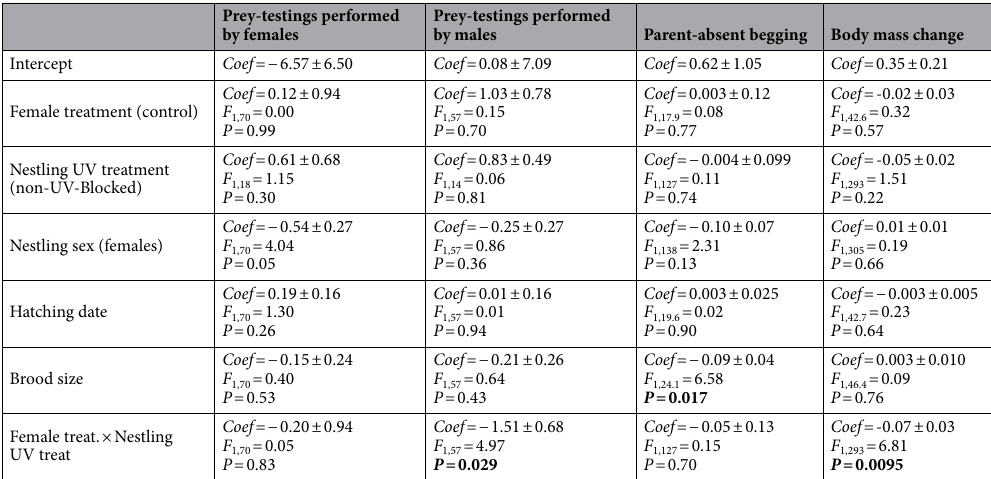
Prey-testings performed Prey-testings performed by females by males Parent-absent begging Body mass